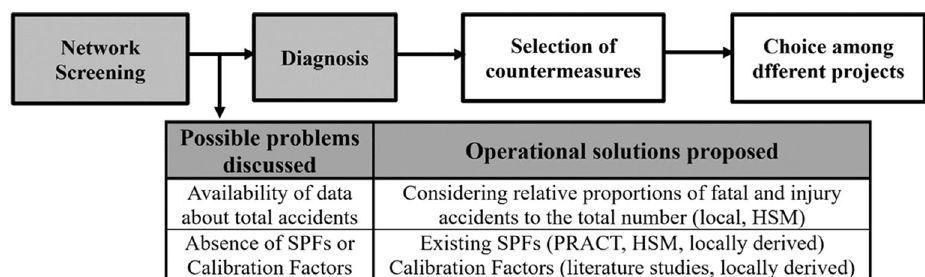
Fig. 2 Intermediate stage between screening and diagnosis. Problems and